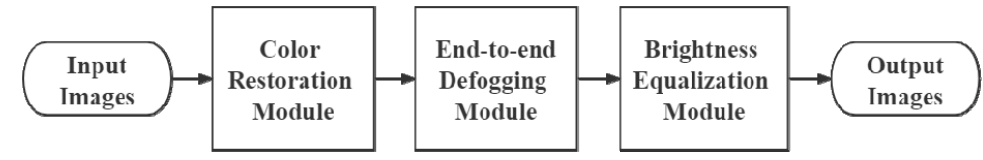
Figure 2. The process of the fusion algorithm.